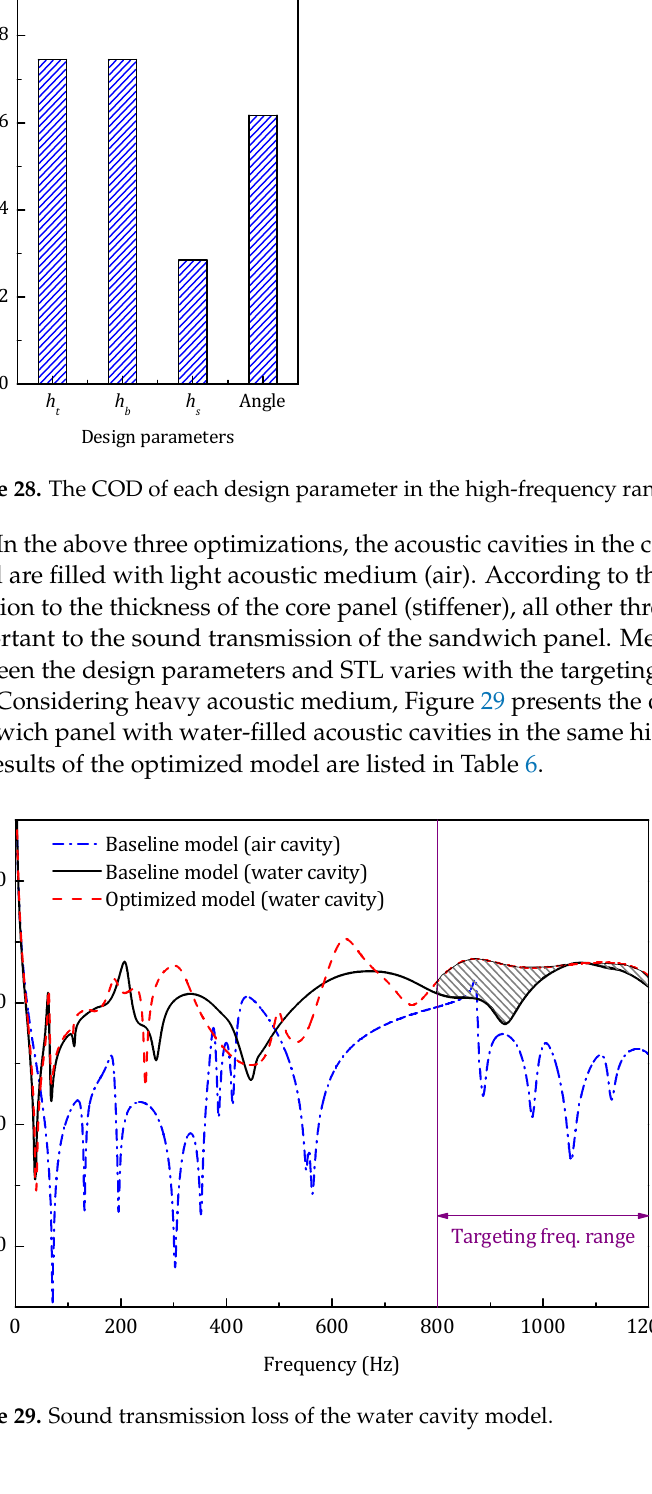
Figure 29. Sound transmission loss of the water cavity model.